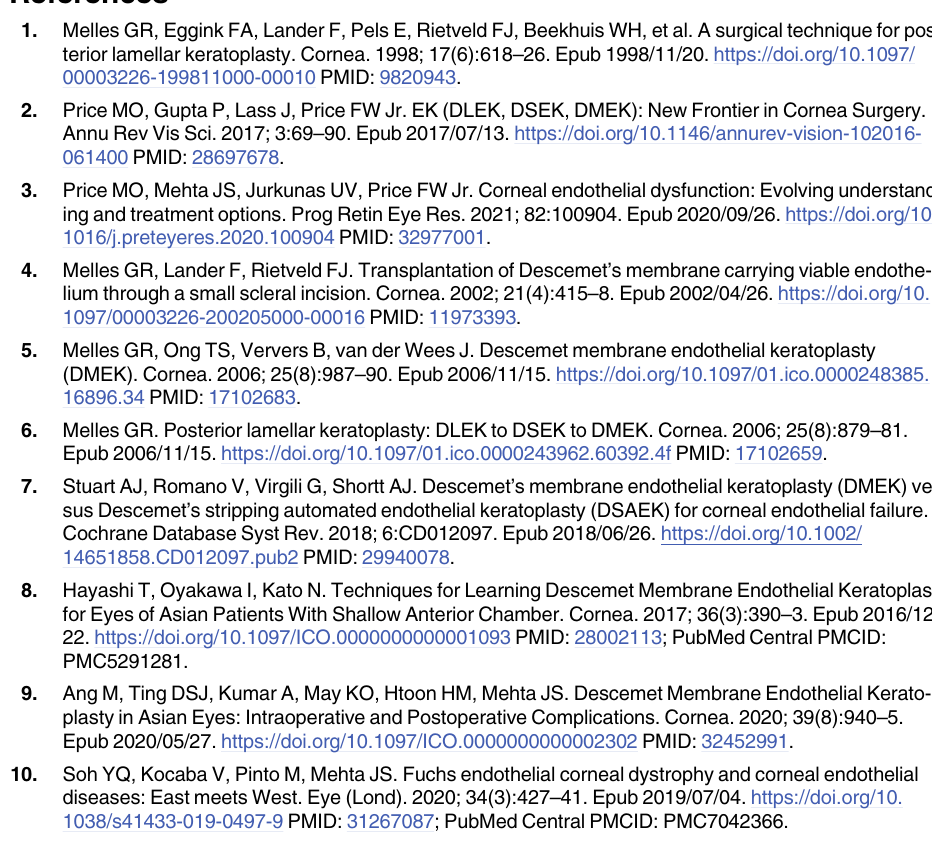
S1 Fig. Graphs comparing the changes of the axial length (AXL) in eyes with Descemet membrane endothelial keratoplasty (DMEK) between preoperative (pre-op) and postoper- ative (post-op) groups, which were measured by IOLMaster 700. Data are expressed as mean ± standard error of the